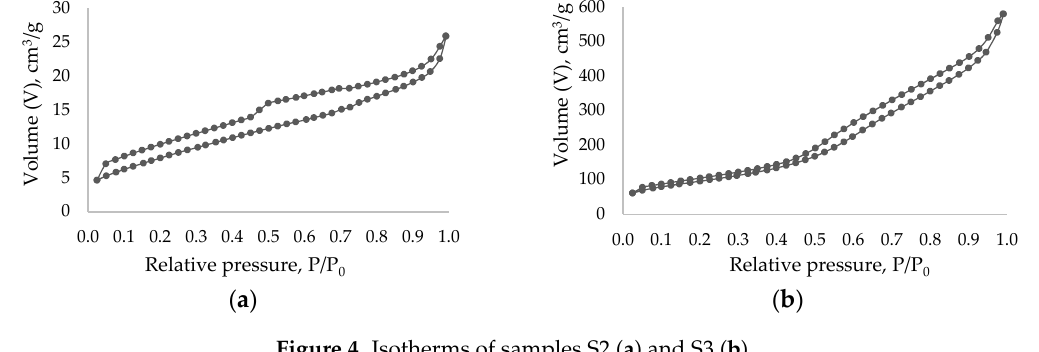
Figure 4. Isotherms of samples S2 ( a ) and S3 ( b ).